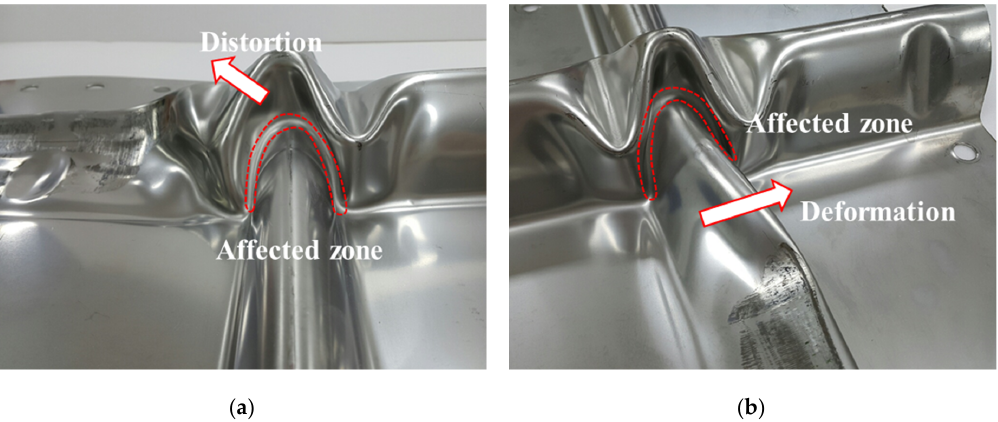
Figure 10. Affected area at the knot part distorted by ( a ) deformation of large corrugation and ( b )